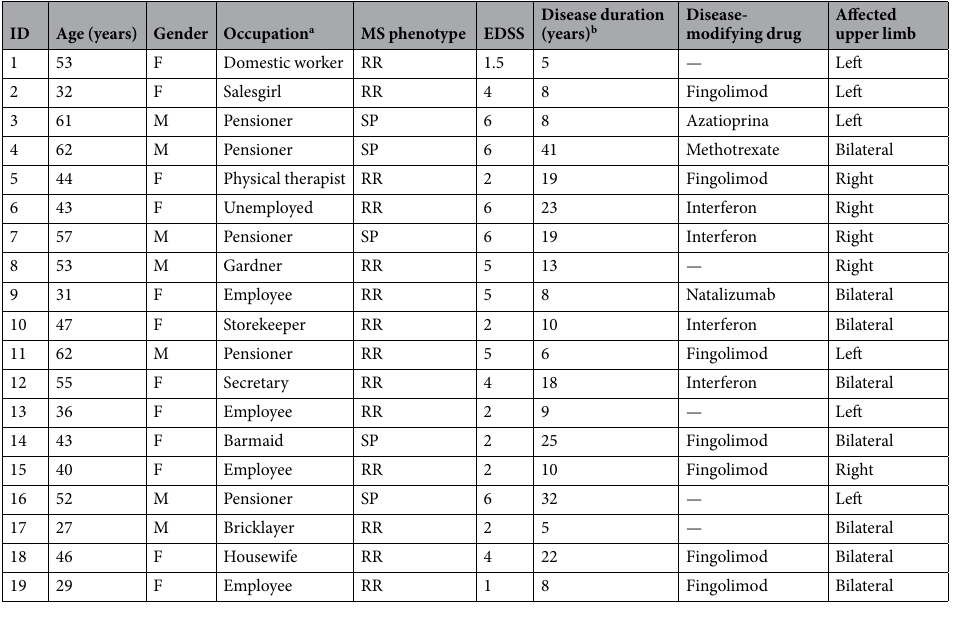
Table 3. Demographic and clinical characteristics of the patients included in the study. RR =